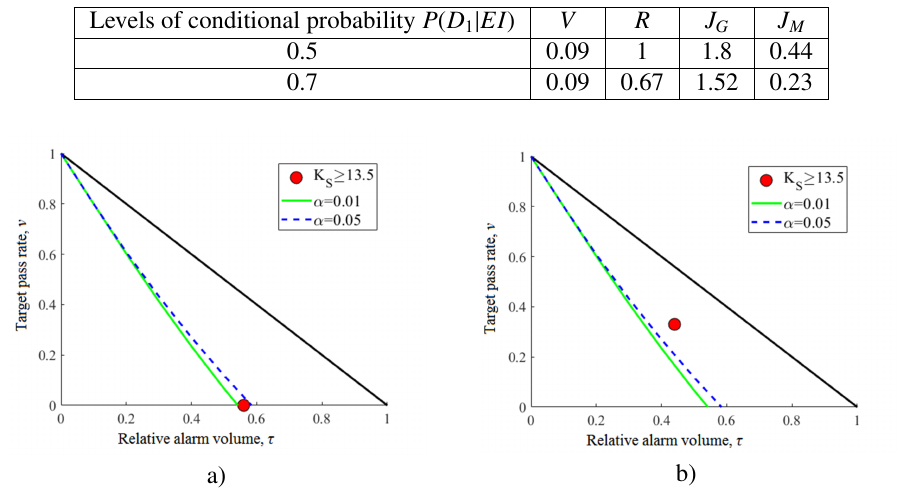
Figure 7. The diagram of errors for the method of earthquakes prediction with K S ≥ 13 . 5 ( M ≥ 6 . 0) based on joint analysis of seismological and complex of ionospheric precursors for chosen levels of the conditional probabilities P ( D 1 | EI ) = 0 . 5 (a) and P ( D 1 | EI ) = 0 . 7